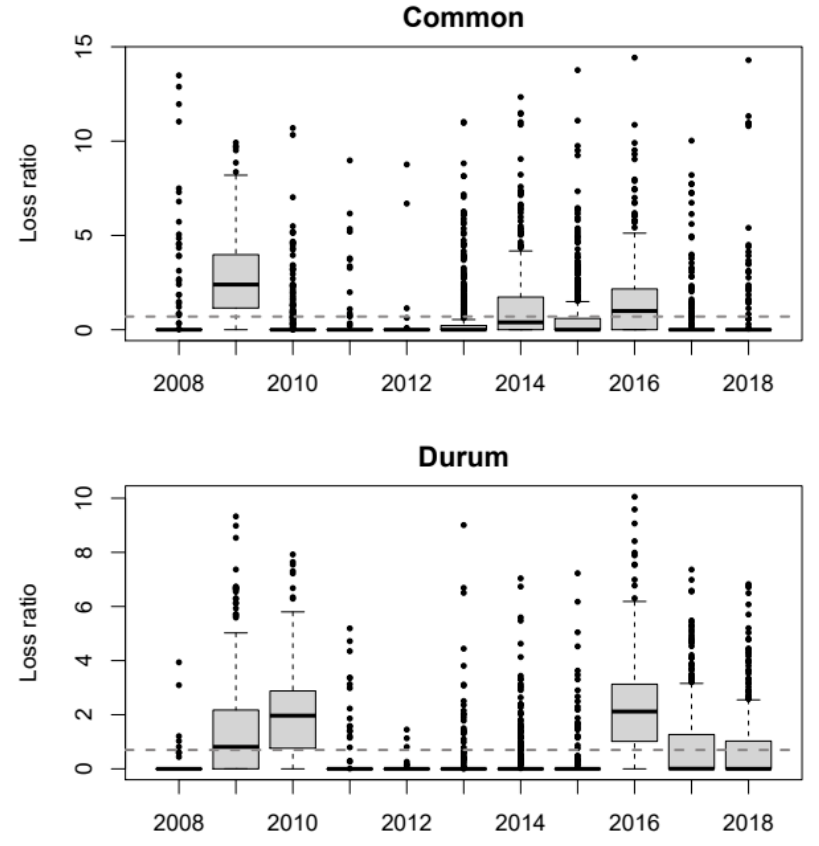
Figure 2. Boxplots of (individual) loss ratio distribution for each year (break-even point 0.7 indicated by dashed grey line).